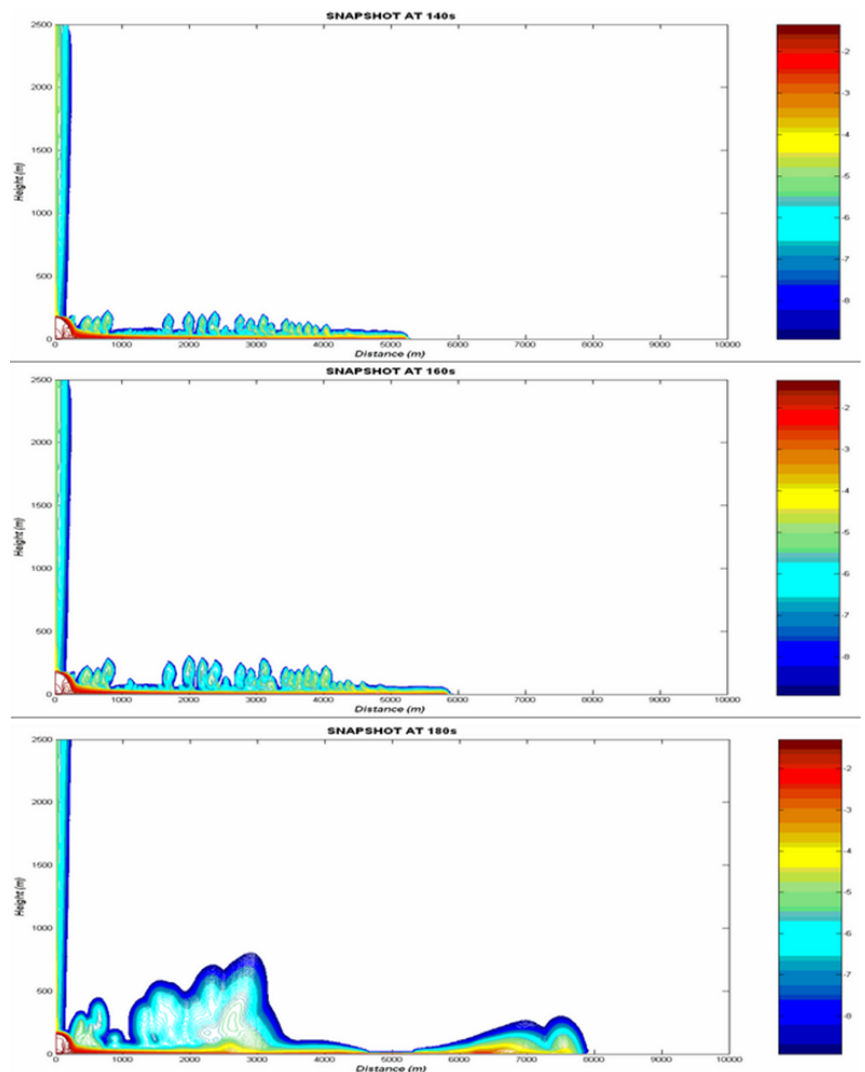
Fig. 2c. Snapshots of the solid particle concentration (logarithmic scale) as a function of distance and height at 140s, 160s, and